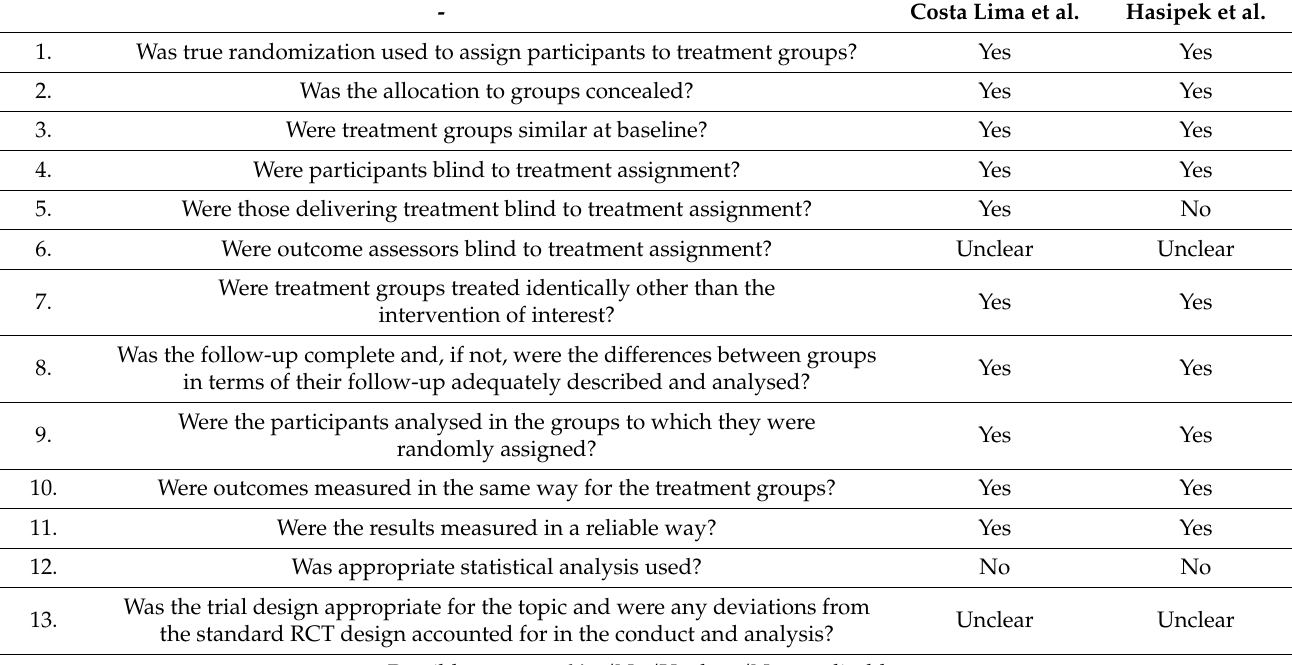
Table 1. The quality analysis of randomized clinical trials using the JBI critical appraisal tool: checklist for randomized clinical